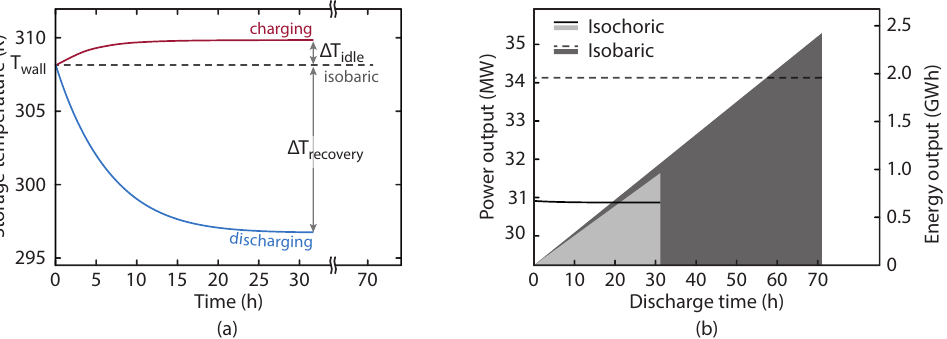
Figure 7. Composite plot depicting: ( a ) storage temperature variation during the isochoric system charging and discharging periods (red and blue lines, respectively), as well the constant isobaric system temperature throughout charging and discharging. Additionally, the difference between final charging and initial discharging temperatures corresponds to the idle period temperature drop ( ∆ T idle ), whilst the opposite corresponds to the recovery period temperature increase ( ∆ T recovery ). ( b ) power generation (left, lines) and cumulative energy generation (right, shaded areas) during the discharging period for both systems. Note the isobaric scenario runs for longer than the isochoric. Data generated for ∆ η =